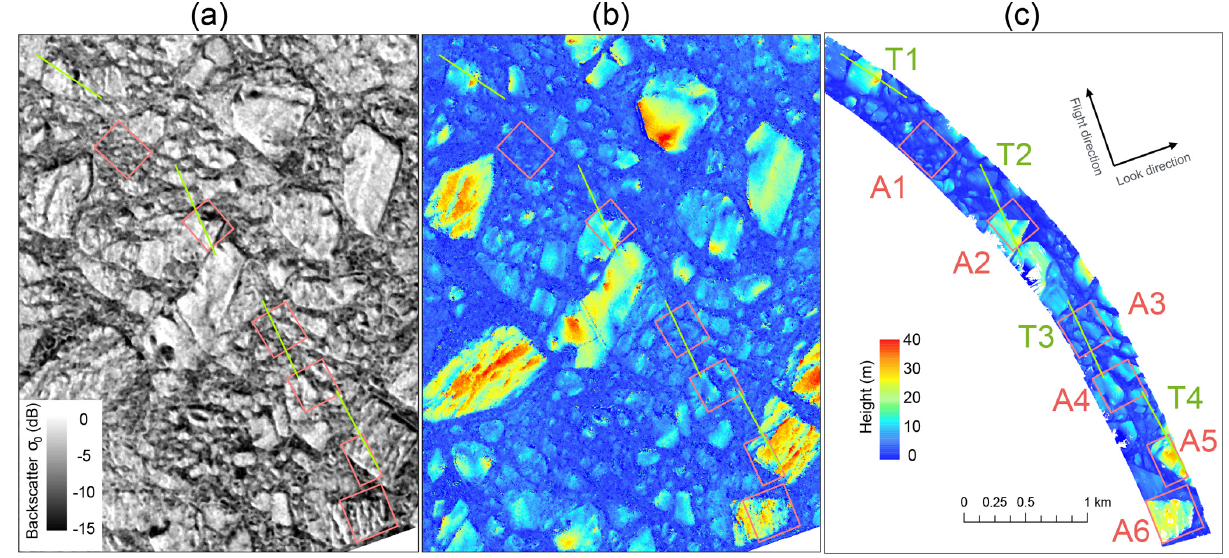
Figure 4. Backscatter (a) and InSAR DEM (b) over the validation area. Panel (c) is the validation DEM (DMS DEM). Red rectangles signify individual validation areas. Green lines signify validation cross